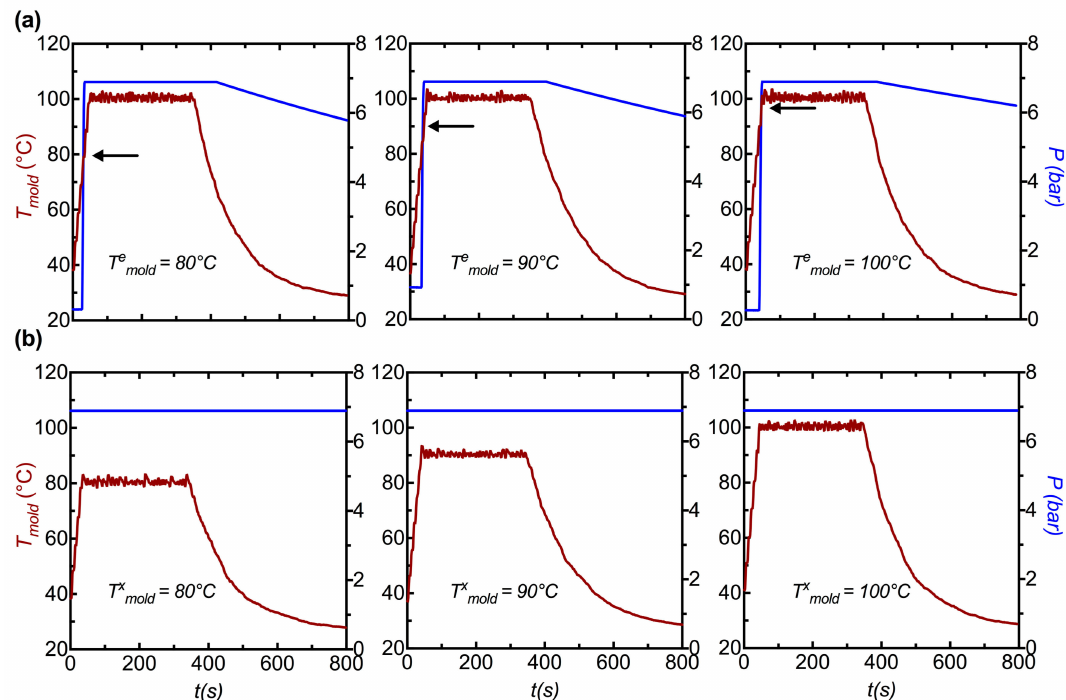
Figure 3. The transient temperature (red traces) and pressure (blue traces) profiles are presented in ( a ) for the first mode of operation and in ( b ) for the second mode of operation. In ( a ), inflation is triggered at a set mold temperature ( T e mold = 80, 90 and 100 ◦ C) and the tube is subsequently annealed at a mold temperature of 100 ◦ C for 5 mins prior to cooling. In ( b ), the tubes are pressurized prior to heating (note the constant pressure trace) and instead the tubes are annealed at three different mold temperatures ( T x mold = 80, 90 and 100 ◦ C) for 5 mins prior to cooling. Numerical simulations described in the SI (Figures S2 and S3) predict that mold temperatures of 80, 90 and 100 ◦ C translate to preform temperatures of ~105, 115 and 125 ◦ C